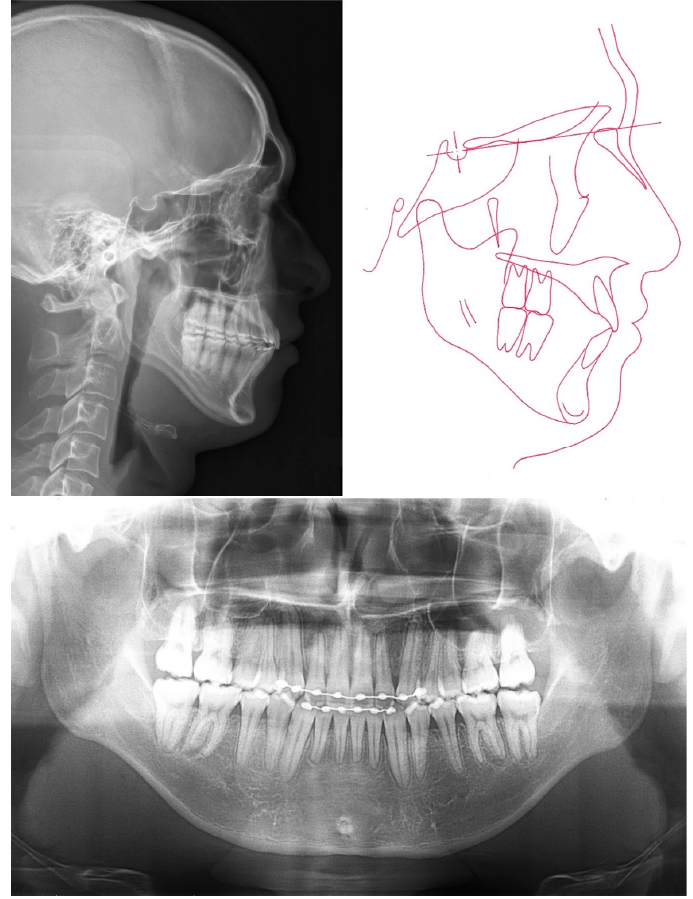
Figure 8. Post-treatment lateral cephalometric, cephalometric tracing, and panoramic radiographs.